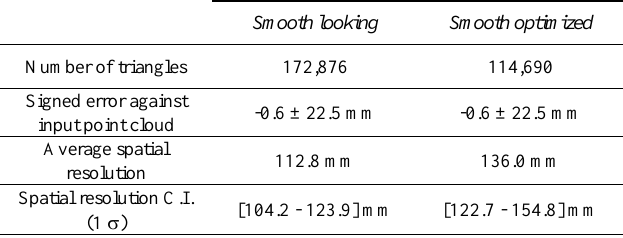
Table 5. Result of the smooth simplification method.